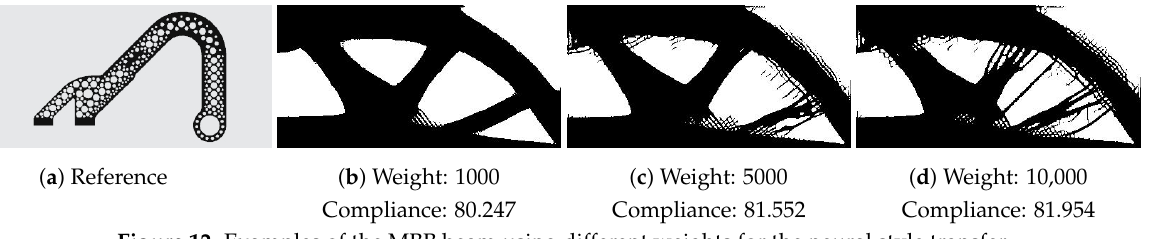
Figure 12. Examples of the MBB beam using different weights for the neural style